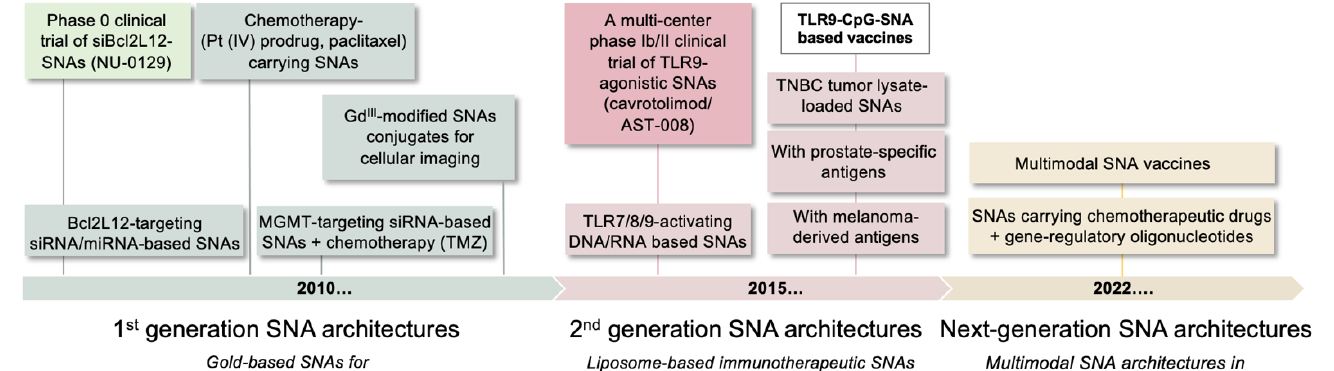
Figure 1. Timeline of SNA preclinical and clinical development. First-generation SNA architectures focused on gene-regulation and the delivery of chemotherapeutic and imaging agents. Second generation SNAs are liposomal structures designed to active anti-tumor immune responses. Next- generation SNAs are multimodal structures, functionalized with multiple therapeutic cues. Bcl2L12, Bcl2Like12; TMZ, temozolomide; TLR, Toll-like receptor; TNBC, triple negative breast cancer.